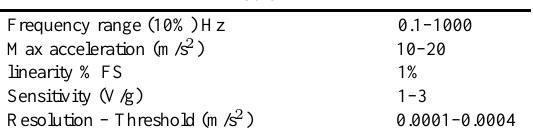
Fig. 2. Theoretical solution for beam midpoint displacement when a sine plus constant load travel on it at constant speed and frequency of exiting force is lower that first beam resonance (upper), equal to beam resonance (medium), higher than beam resonance (lower). is therefore becoming increasingly important.